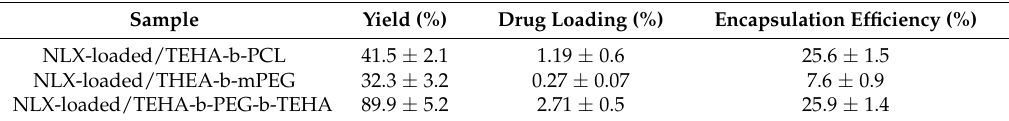
Table 2. Percentage yield, drug loading and encapsulation efficiency of prepared